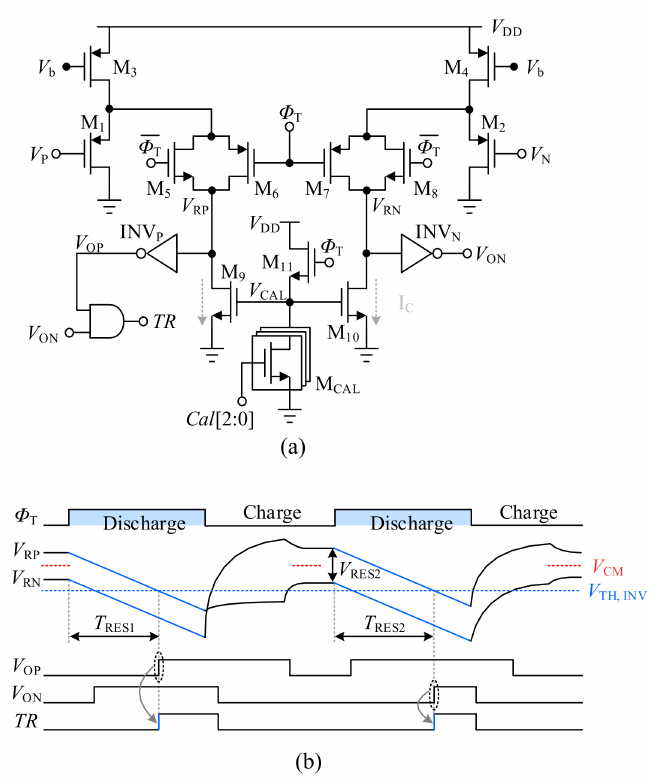
Figure 5. ( a ) Design of the proposed VTC and ( b ) timing